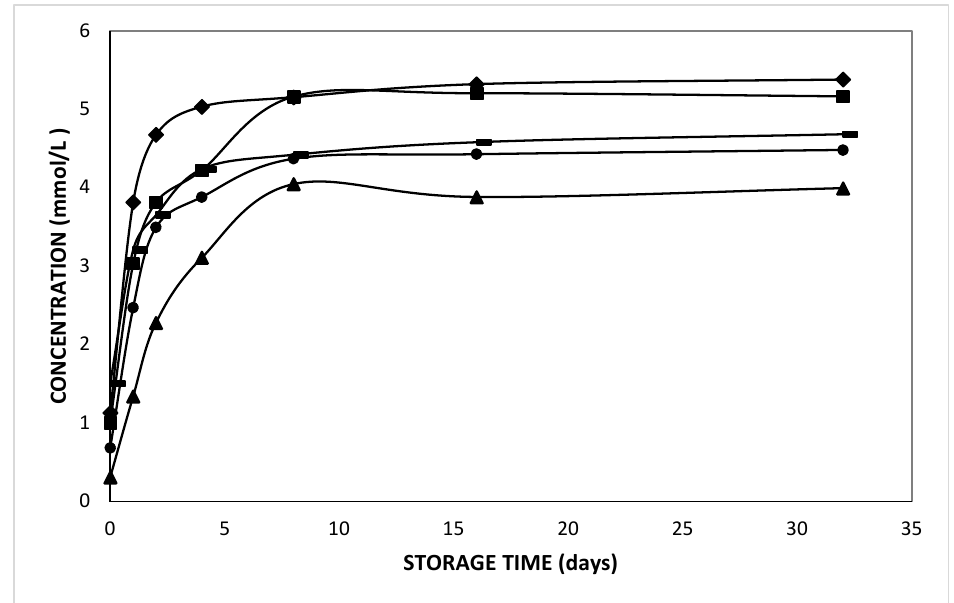
Figure 6. Released L-leucine concentration in the external phase of double emulsions containing 5 mmol/L L-leucine at pH 1 (triangles), pH 2 (circles), pH 3 (dashes), pH 4 (squares), and pH 7 (diamonds) prepared with HOSO during storage at 37 °C.